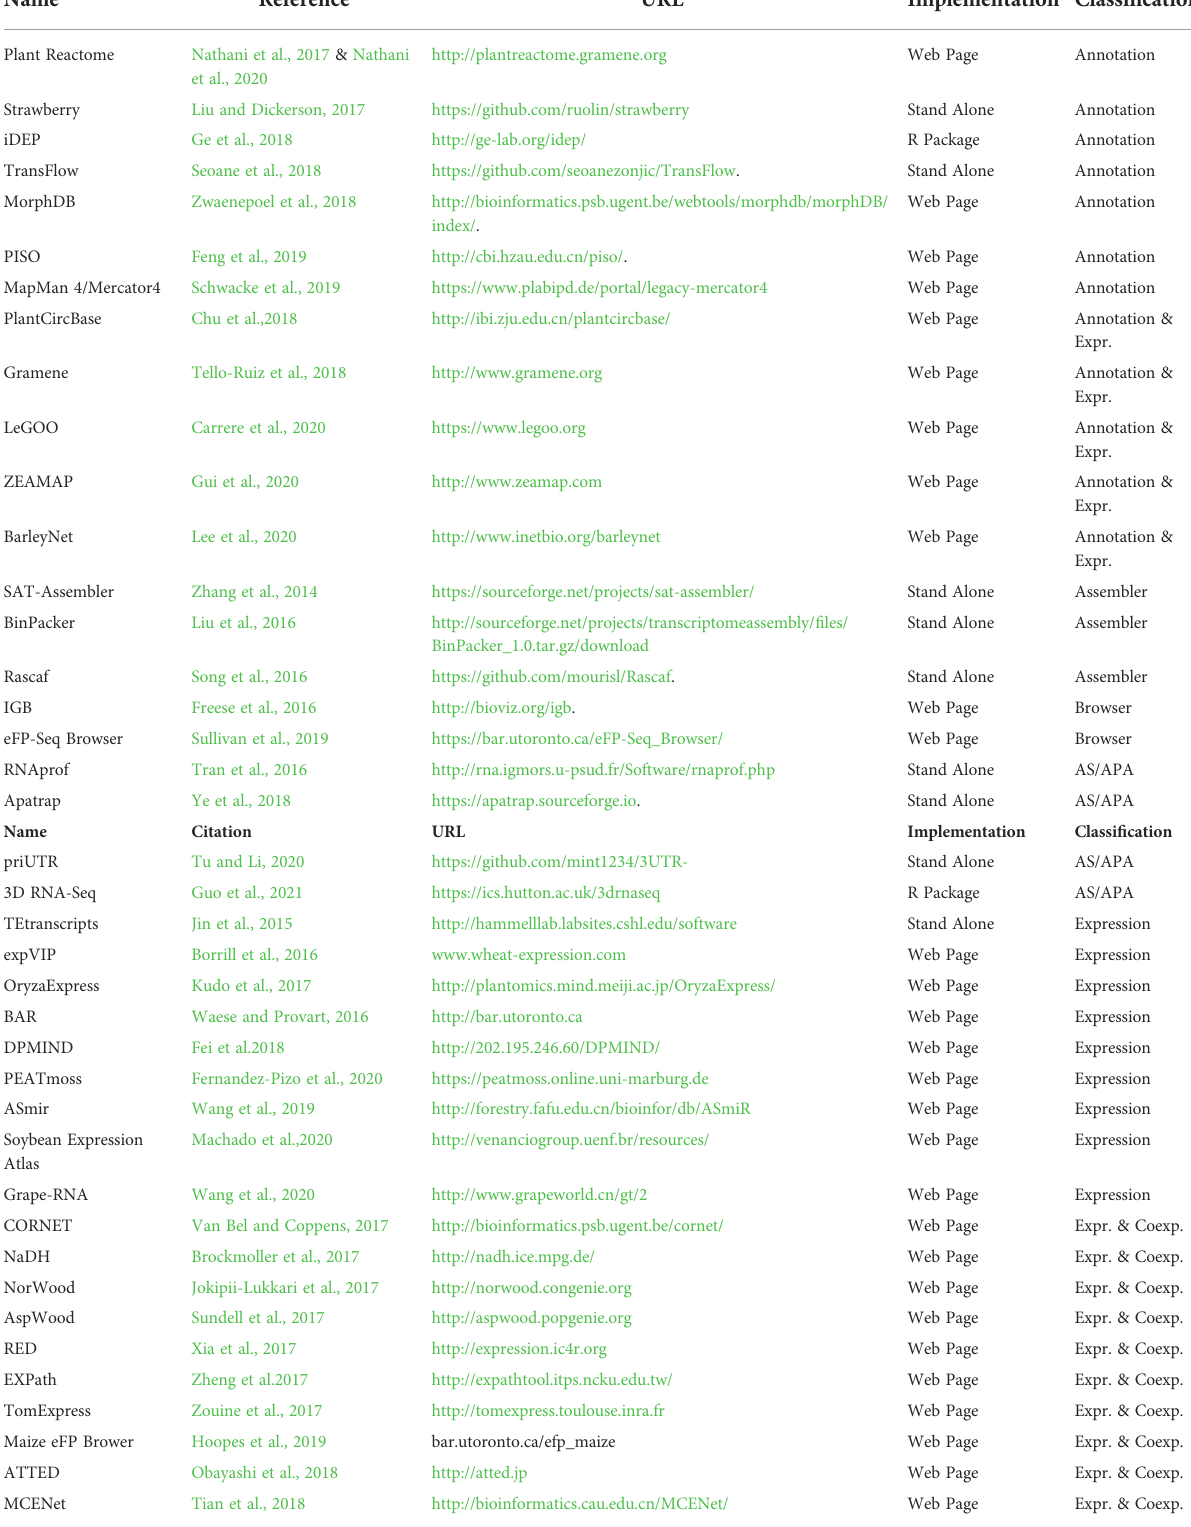
TABLE 1 Summary of the representative resources and tools for analyzing the short-read RNA-seq data in